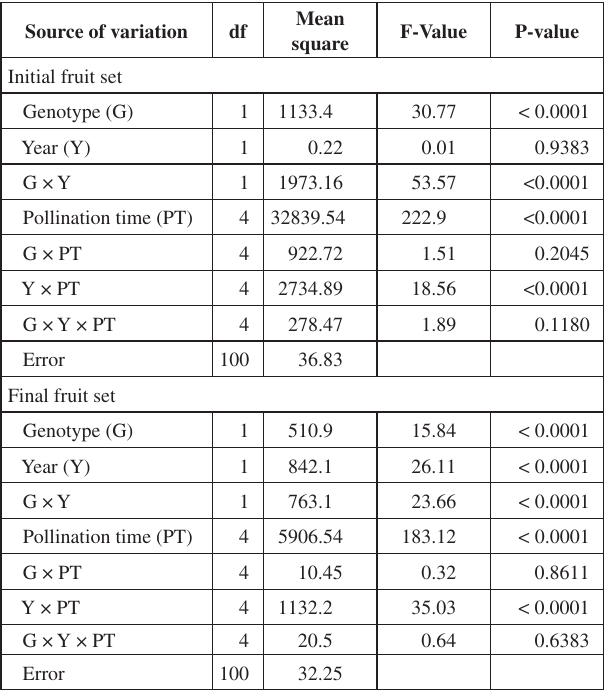
Table 1. Analysis of variance for initial and final fruit set in 2008 and 2009